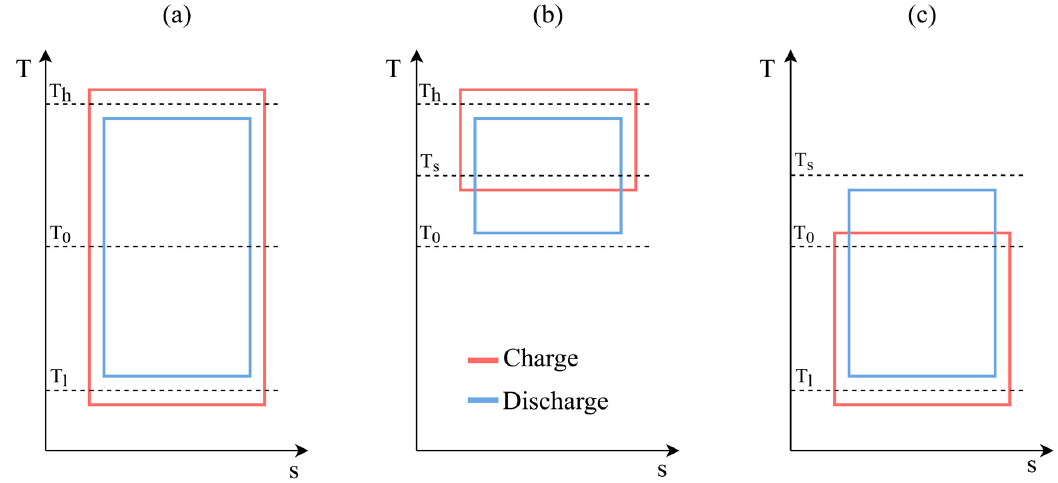
Figure 3. PTES working principle with idealised Carnot cycles. ( a ) Traditional PTES. ( b ) TI-PTES with only the high-temperature thermal reservoir. ( c ) TI-PTES with only the low-temperature thermal reservoir. T and s are the temperature and the specific entropy, respectively; T h , T s , T 0 , T l are the temperature of the hot reservoir, heat source, environment and cold reservoir, respectively.